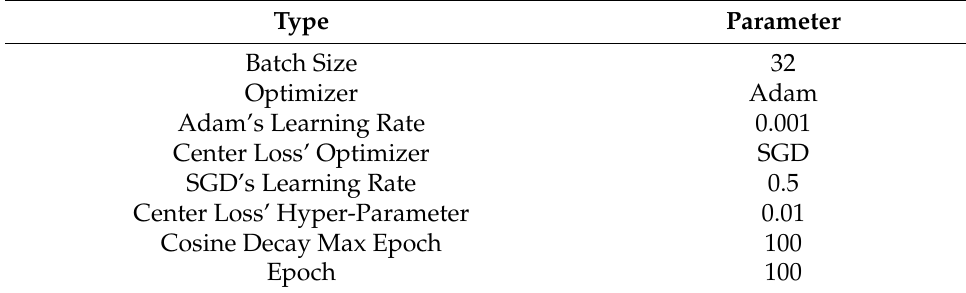
Table 4. Direct training parameter